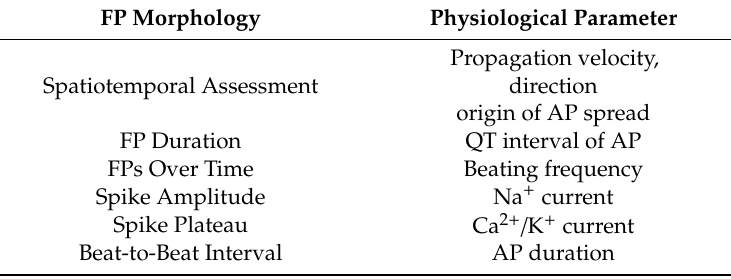
Table 1. Functional parameters acquired by FP measurements using MEA